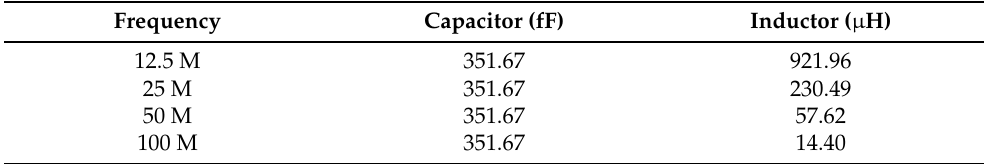
Table 2. One round of PRESENT inductor and capacitor values at various frequencies.